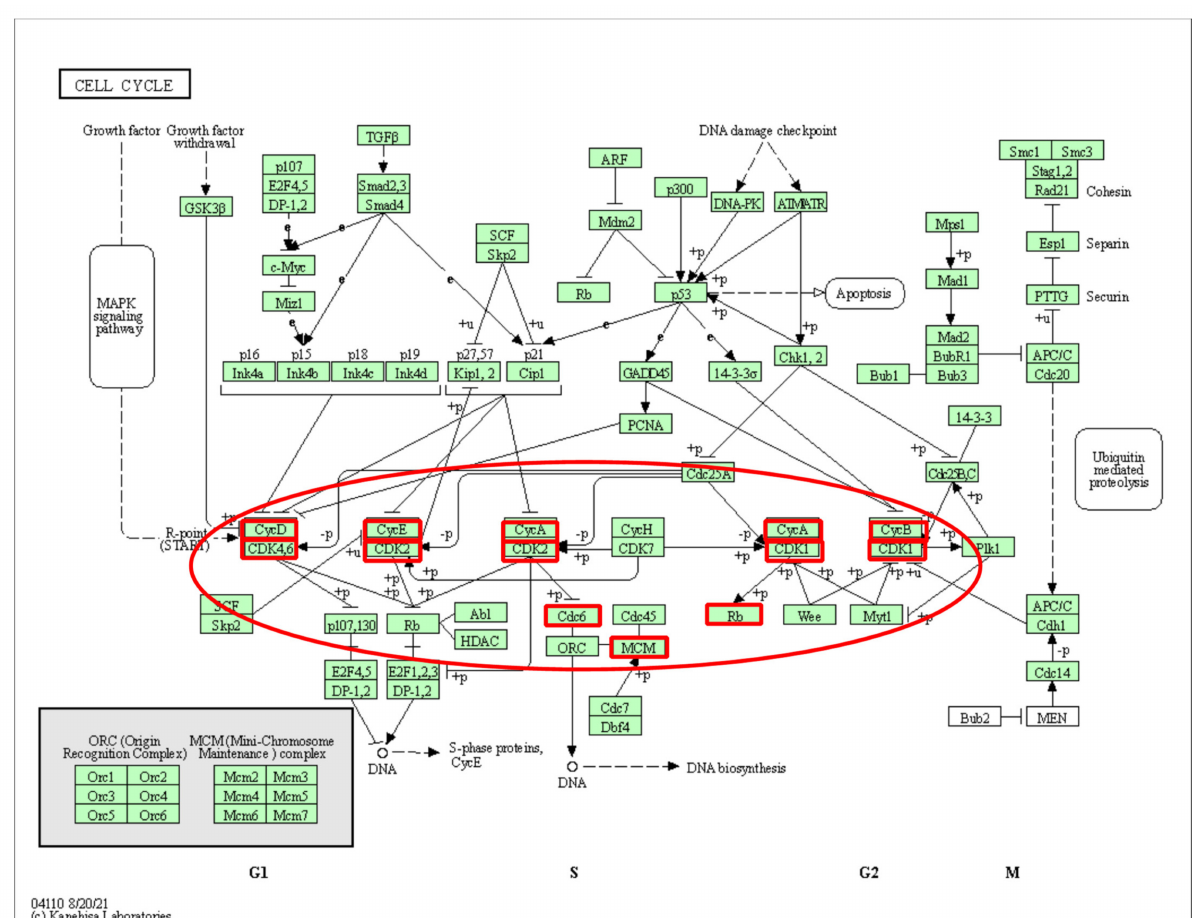
Figure 10. The cell cycle pathway in KEGG. Red borders represent genes mapped to the subpathway from GSE68465. Key subpathway region is shown in red